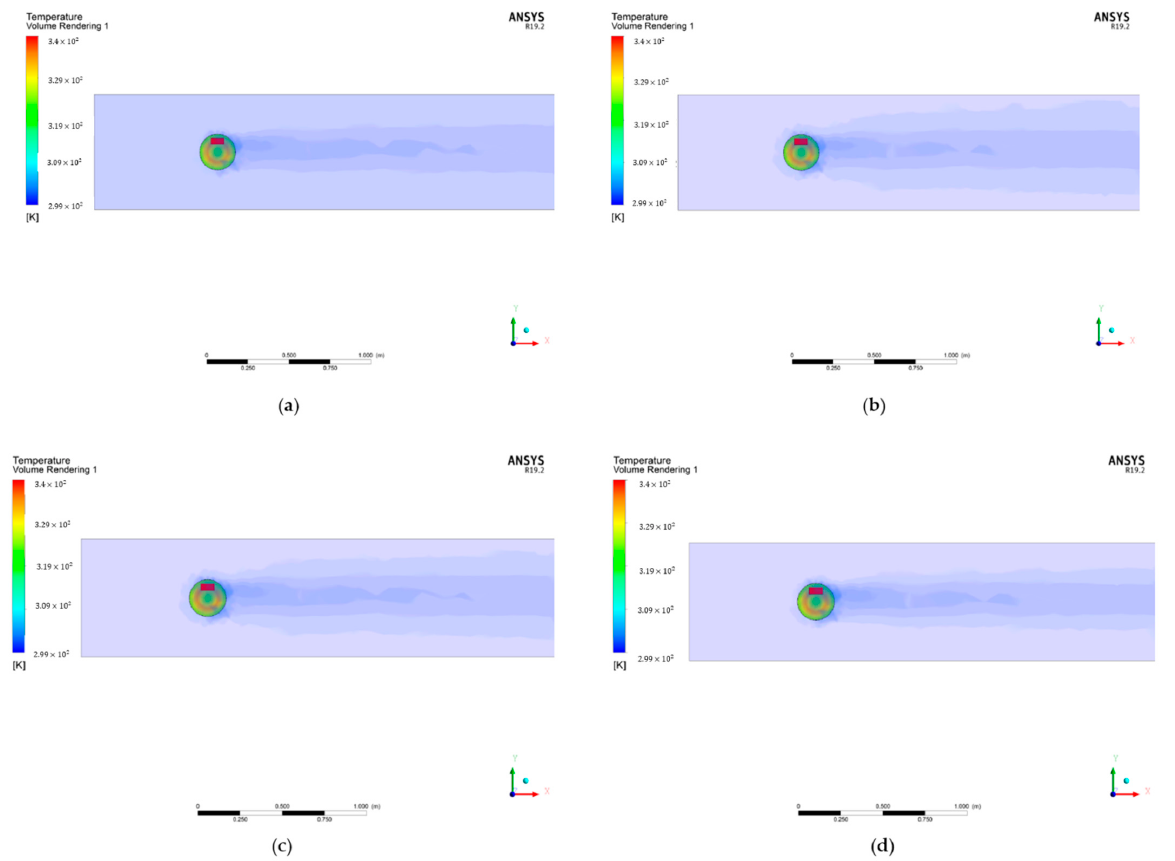
Figure 9. The process of releasing heat that occurs at the speed of: ( a ) 80 km/h, ( b ) 60 km/h, ( c ) 40 km/h and ( d ) 20 km/h.